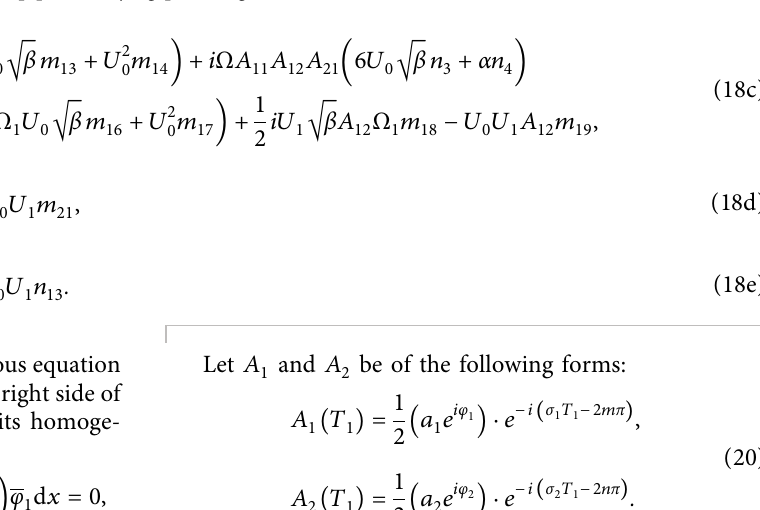
Figure 2: The Campbell diagram of the cantilevered pipe conveying pulsating fluid is obtained in the case of 1:3 internal